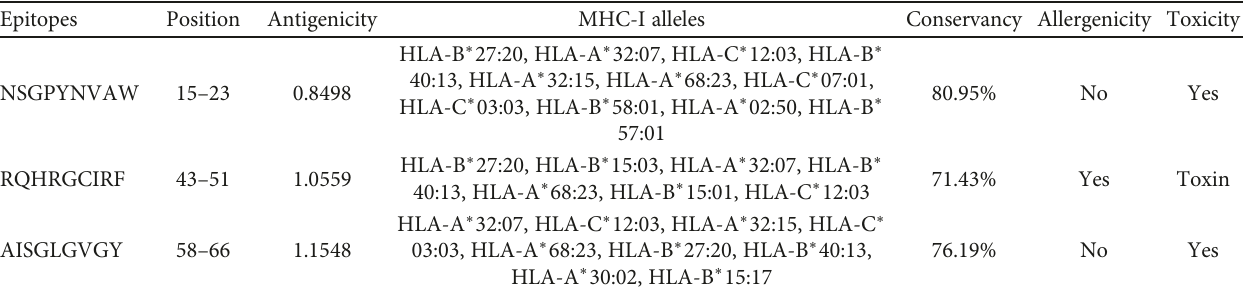
35:01 were found as common in both “ TSSWGCEEY ”